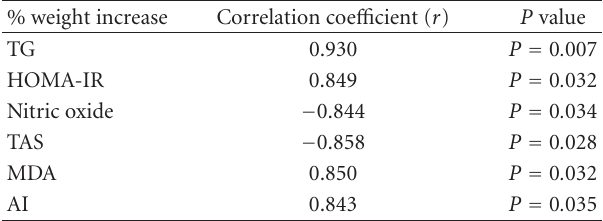
Table 5: Correlation coe ffi cient ( r ) of % wt increase against meta- bolic syndrome